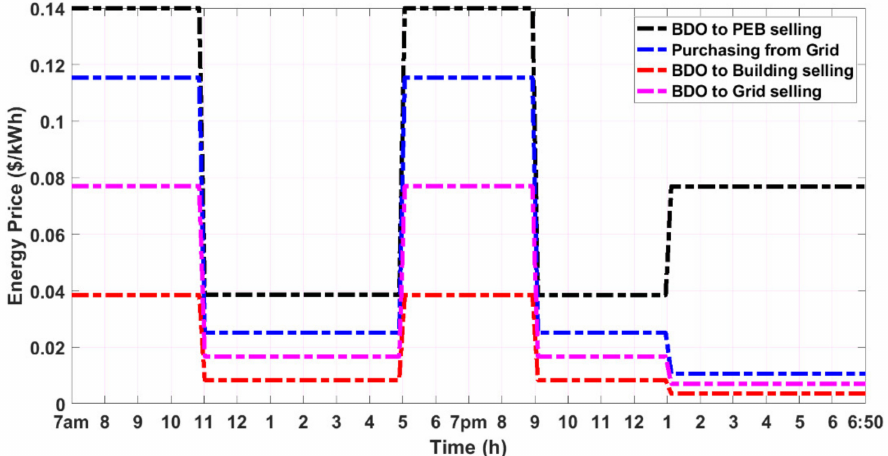
Figure 4. Proposed feed-in tari ff (FIT) scheme for bus depot charging